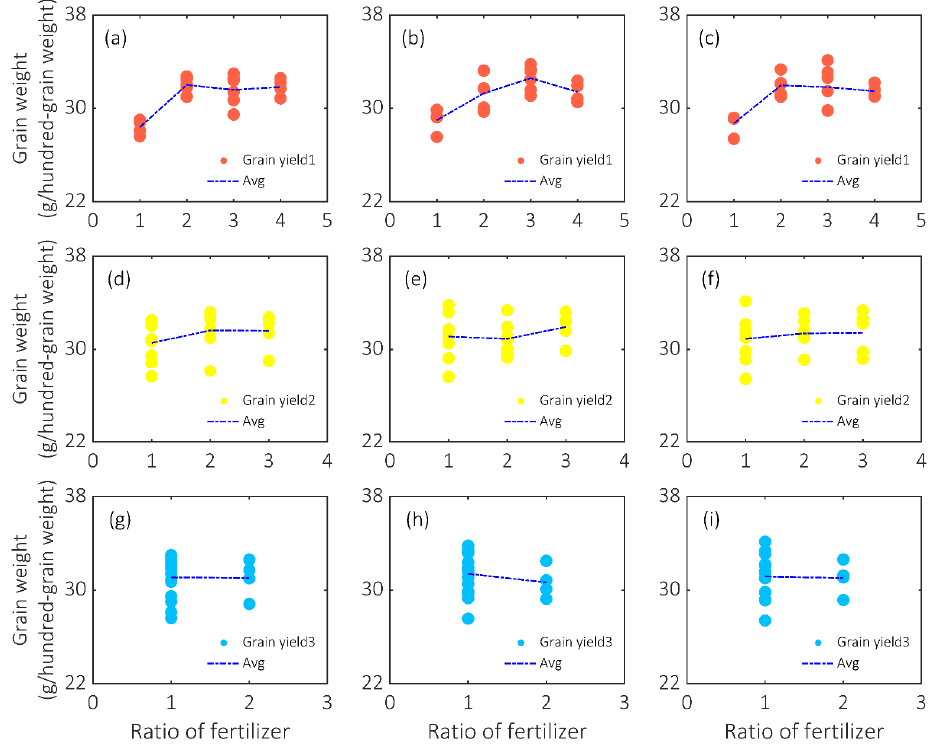
Figure 9. The dynamic changes in ratios of N, P, and K and the corresponding variations of maize grain yields. Note: ( a – c ) Represent the effects of N on maize grain yield1; ( d – f ) represent the effects of P on maize grain yield2; ( g – i ) represent the effects of K on maize grain yield3.